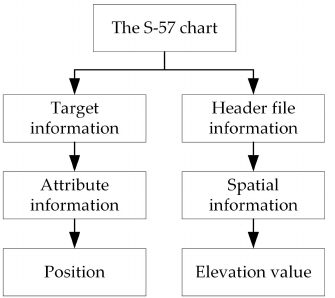
Figure 4. The S-57 Electronic Chart data reading flow.